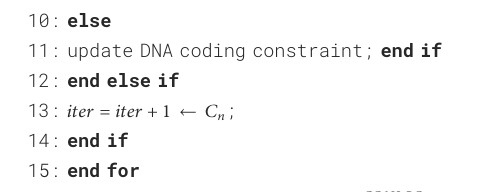
Algorithm 2 Pseudocode of constraints satisfactory criteria with